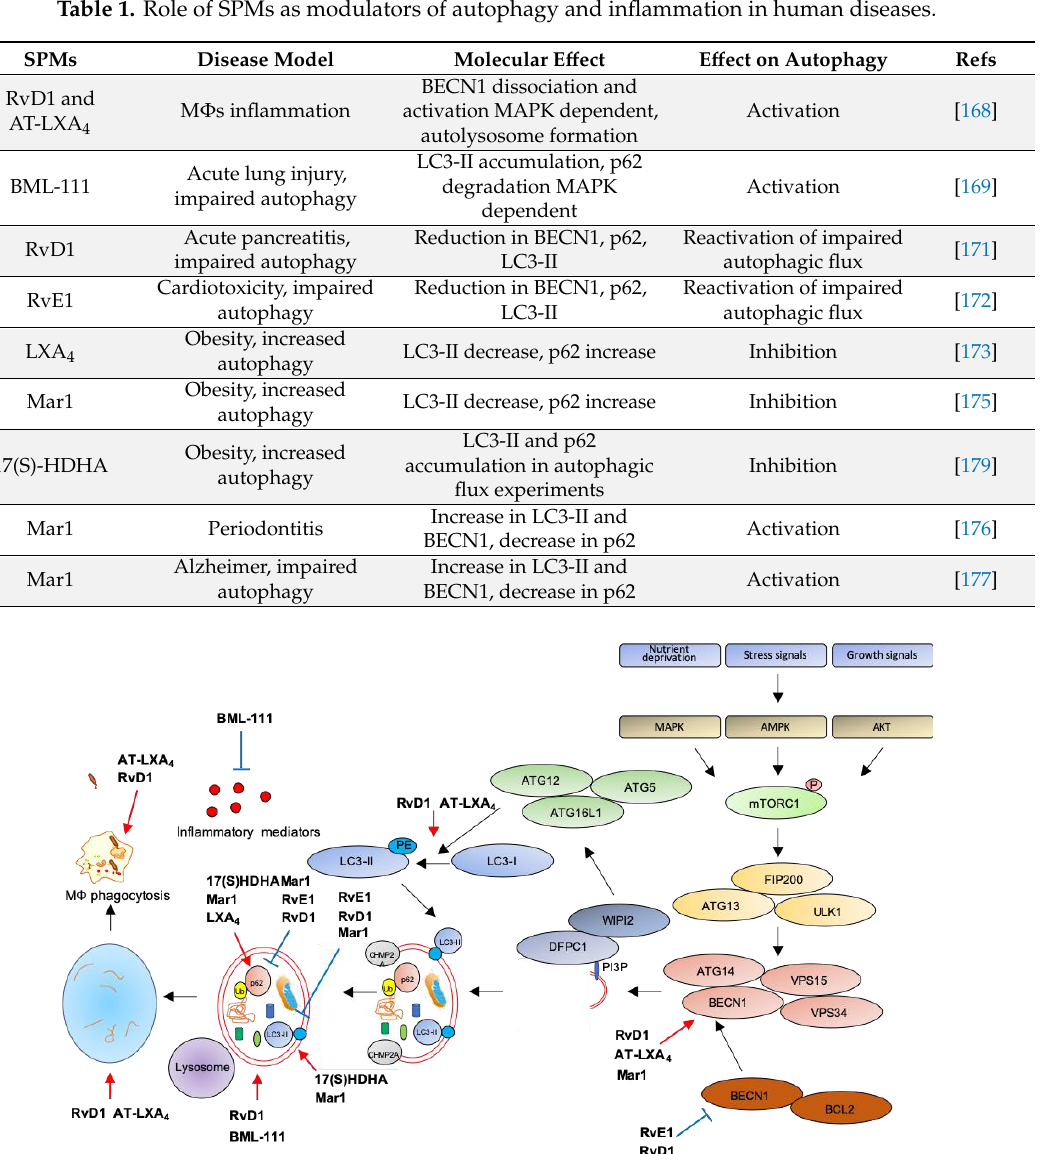
Table 1. Role of SPMs as modulators of autophagy and inflammation in human diseases.